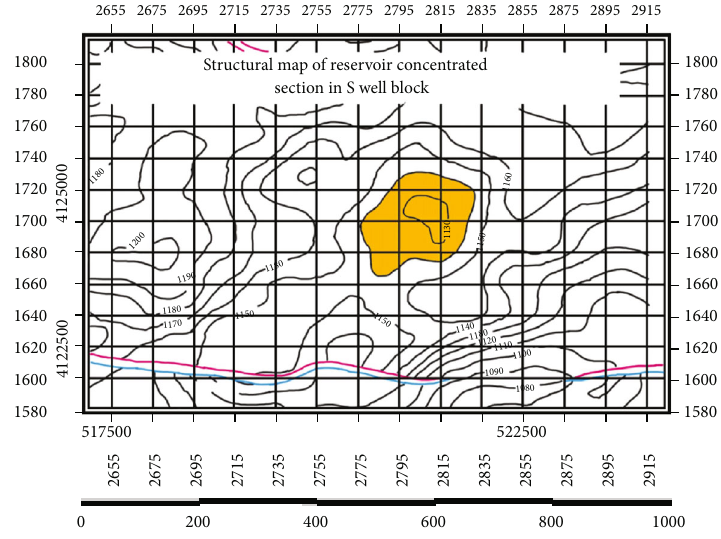
Figure 3: Structural schematic of reservoir concentrated section in S well block.